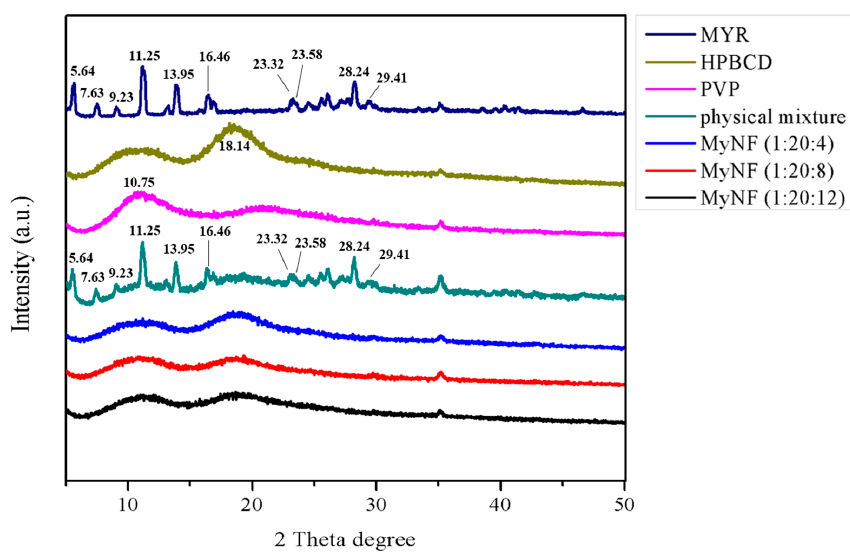
Figure 4. X-ray diffraction (XRD) spectra of MYR, HPBCD, PVP, physical mixture (MYR, PVP, and HPBCD powder), and the different ratios of MyNF (MYR:HPBCD:PVP; 1:20:4, 1:20:8, and 1:20:12; w / w / w ).